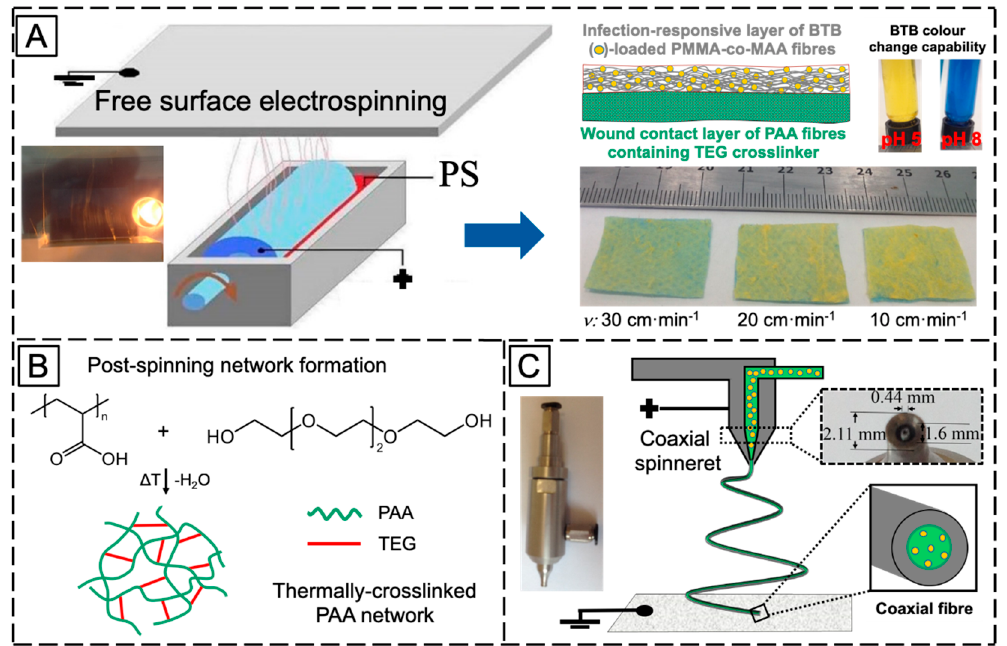
Figure 1. ( A ): Manufacture of the two ‐ layer fibrous configuration via sequential free surface electrospinning of a PAA ( ) wound contact layer containing the TEG crosslinker ( ) and a BTB ( ) ‐ loaded PMMA ‐ co ‐ MAA ( ) infection ‐ responsive layer. BTB was introduced as halochromic dye to trigger colour change following infection ‐ induced pH increase. BTB release was controlled by collecting PMMA ‐ co ‐ MAA fibres at varied collector linear speed ( ν ). ( B ): The two ‐ layer system was thermally ‐ treated to achieve a covalently ‐ crosslinked network in PAA fibres via TEG ‐ induced esterification. ( C ): Manufacture of the single ‐ layer core ‐ shell fibrous configuration via coaxial electrospinning of a fibre shell ‐ forming PMMA ‐ co ‐ MAA solution and a BTB ‐ loaded fibre core ‐ forming PAA solution.